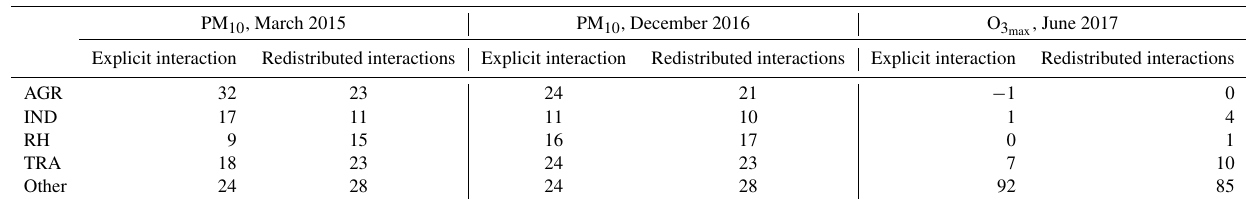
Table 4. Relative contributions (%) of the four main activity sectors as well as natural and background concentrations (“other”) averaged over the three selected air pollution episodes, either with explicit interaction terms or with interactions redistributed within individual contri-